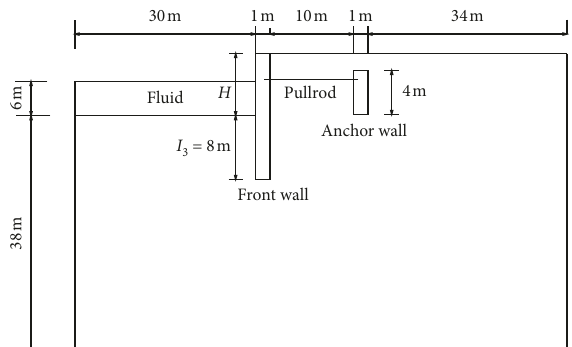
Figure 5: Diagram of the calculation model.